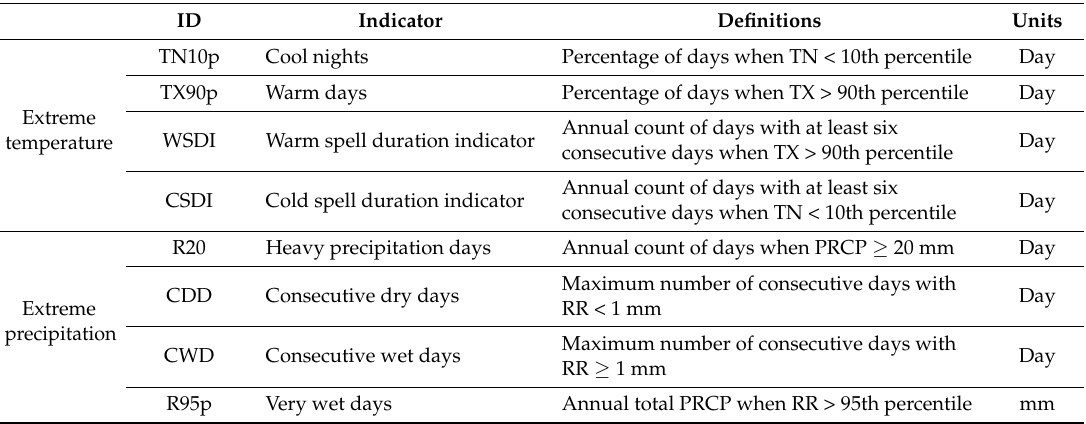
Table 1. Extreme weather